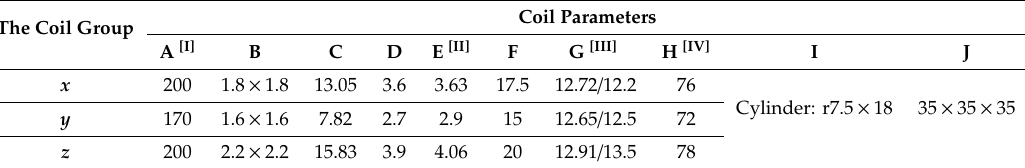
Table 2. Specifications of the hybrid